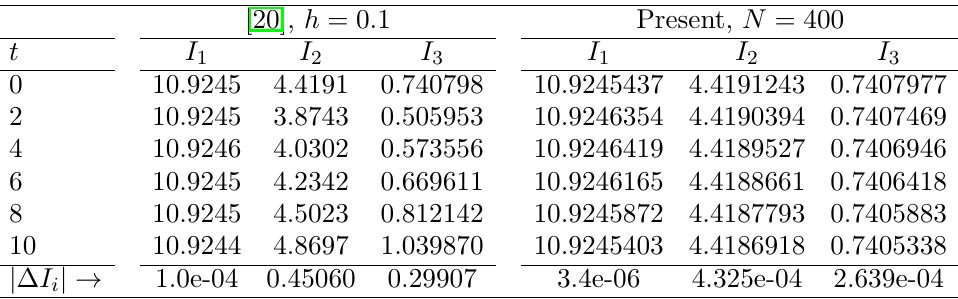
Figure 5. Interaction of two solitary waves for N = 400, p = 3, c 1 = 48 / 5, c 2 = 6 / 5, x 1 = 20, x 2 = 50, ∆ t = 0 . 025 , and µ = 1 at t = 0 , 4 , 8 , 12 , 16 , 20. Table 11. Invariants and their changes for p = 2 and ∆ t = 0 . 1. [20], h = 0 . 1